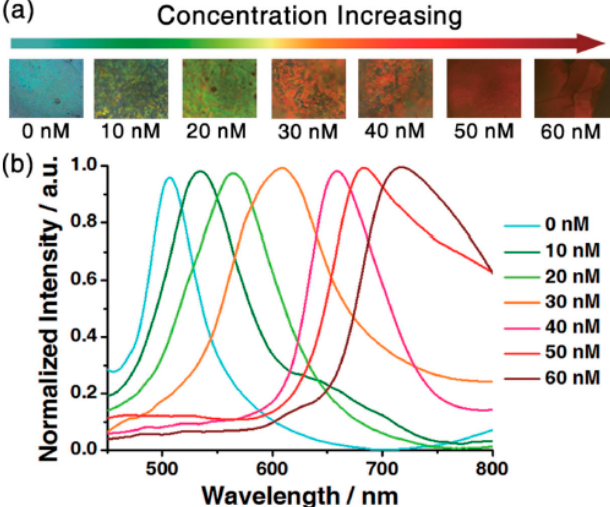
Figure 11. ( a ) The colorimetric transition of the molecularly imprinted polymer-photonic crystals dot as the tetracycline concentration increasing. ( b ) The spectra with different concentrations dried on MIP-PC dots with a diameter of 1.35 mm. Reproduced with permission from [33].